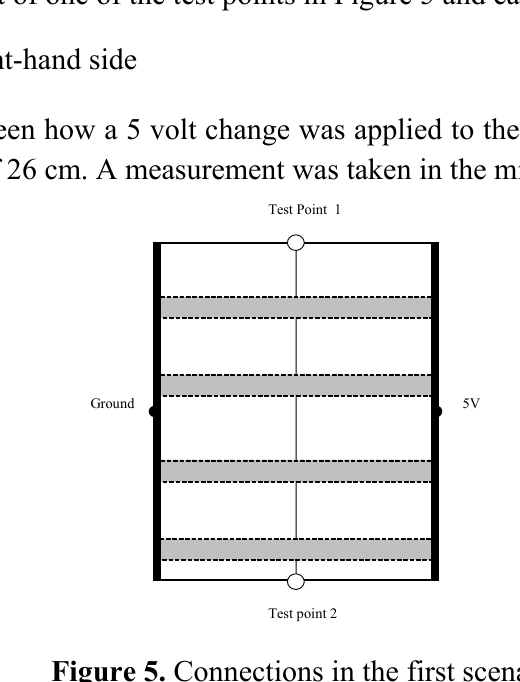
Figure 5. Connections in the first